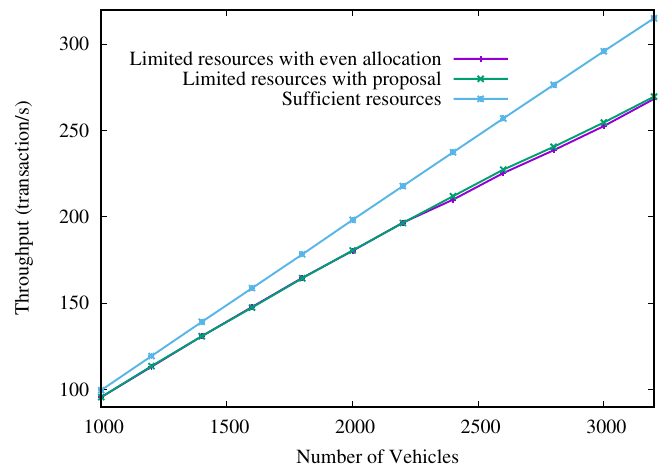
Figure 12. Throughput performance of the system with coexisting